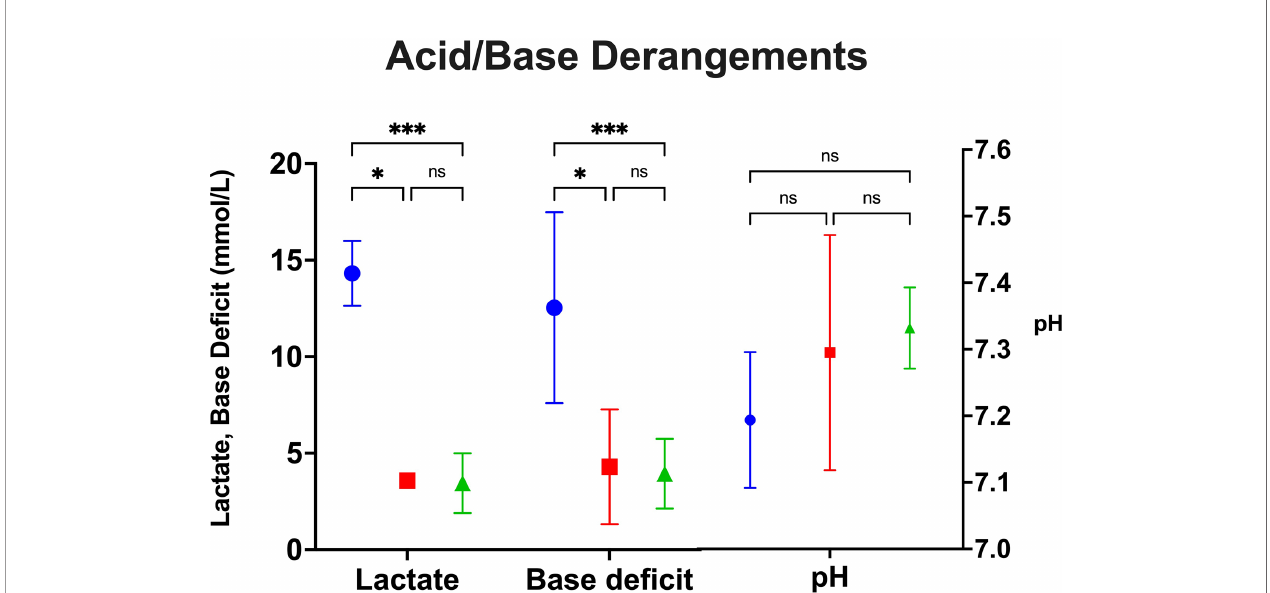
FIGURE 3 | Peak acid/base derangements as measured by lactate, base de fi cit and pH between groups. *p=<0.05, **p<0.005, ***p<0.0005. Blue=Crystalloid Cardioplegia, Red=Blood Cardioplegia, Green=NICP. ns, not signi fi